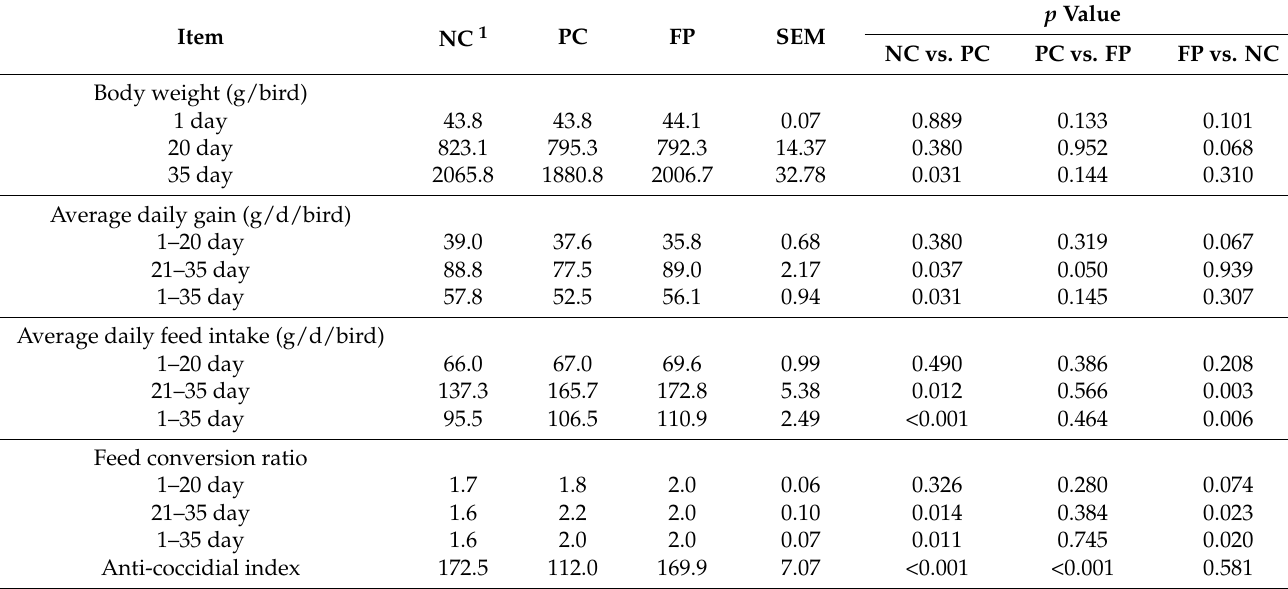
Table 2. Effect of fermented products produced by B. licheniformis on the growth performance and anti-coccidial index of broilers under coccidial challenge.